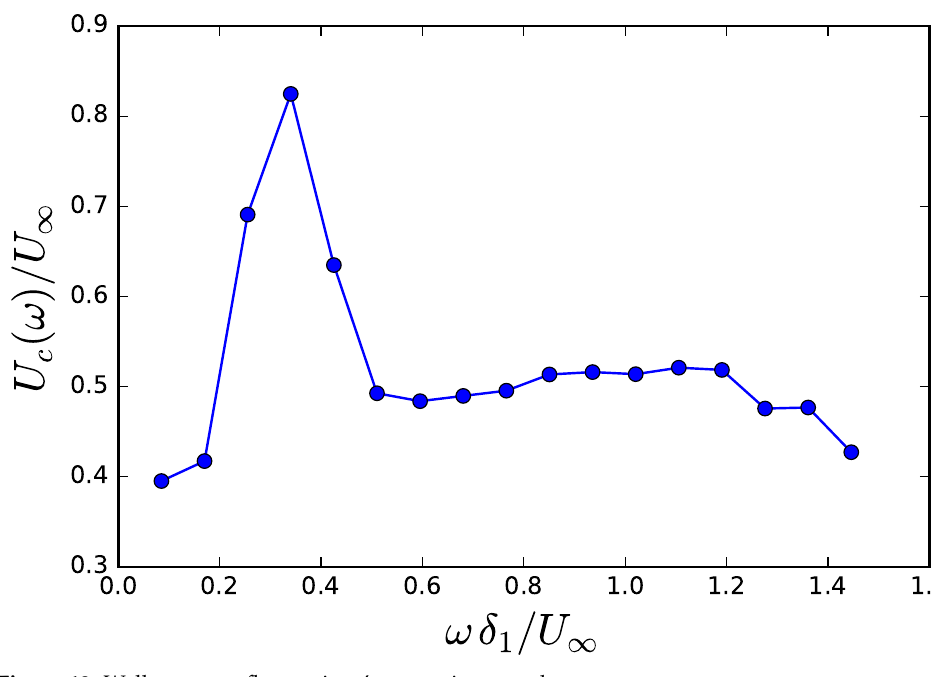
Figure 13. Wall-pressure fluctuations’ convection speed.